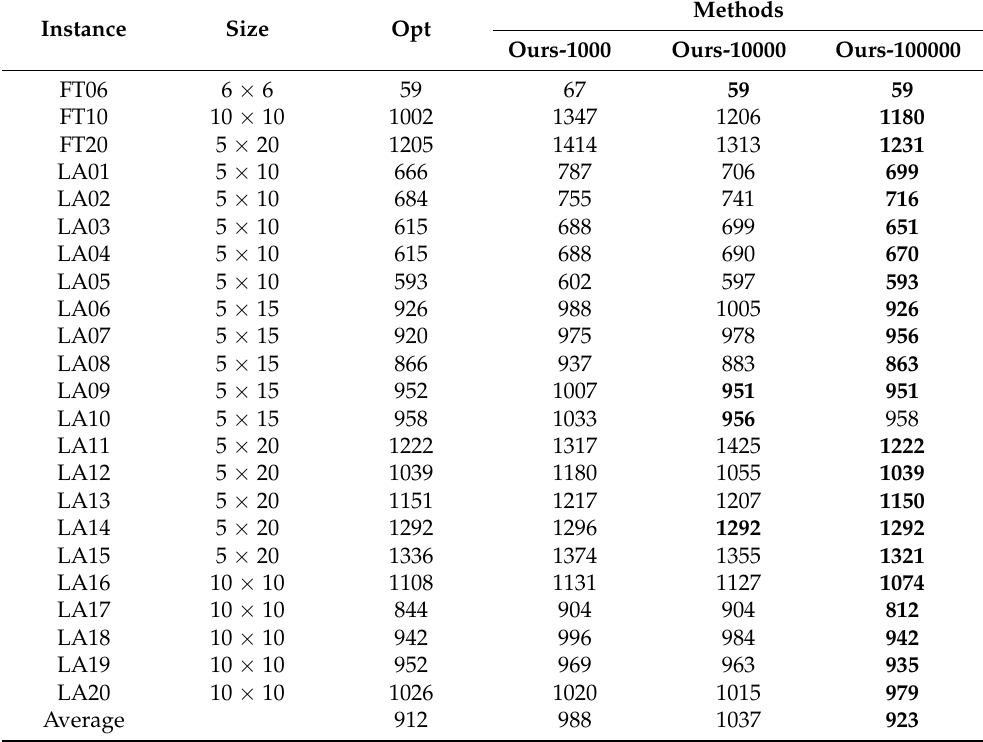
Table A9. The comparison between different SPP-Transformers on